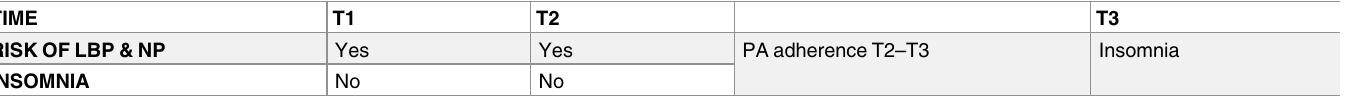
Table 2. Model 2: Examining the effect of PA adherence on subjects with LBP/NP risk profiles that also reported pain at T1, on the risk of develop- ing insomnia (n = 347). TIME T1 T2 T3 RISK OF LBP & NP Yes Yes PA adherence